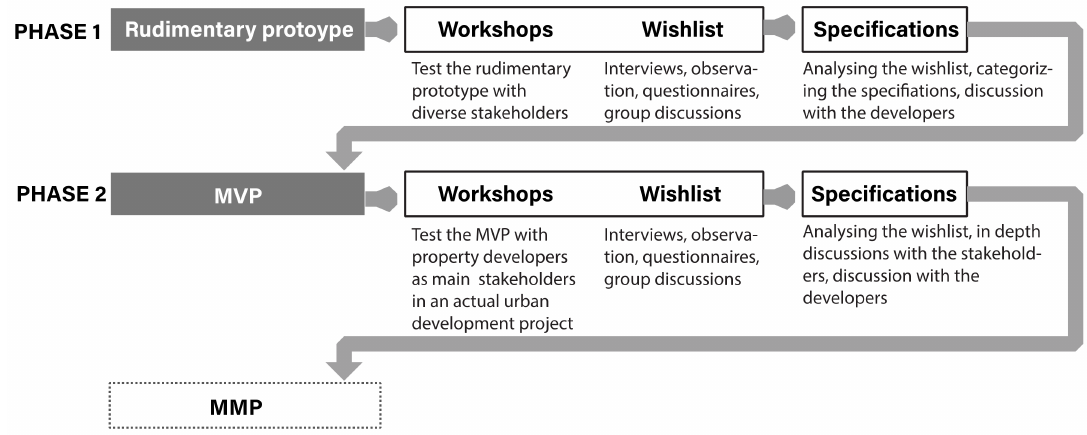
Figure 1. The Urban CoCreation Lab development process, Phases 1 and 2.